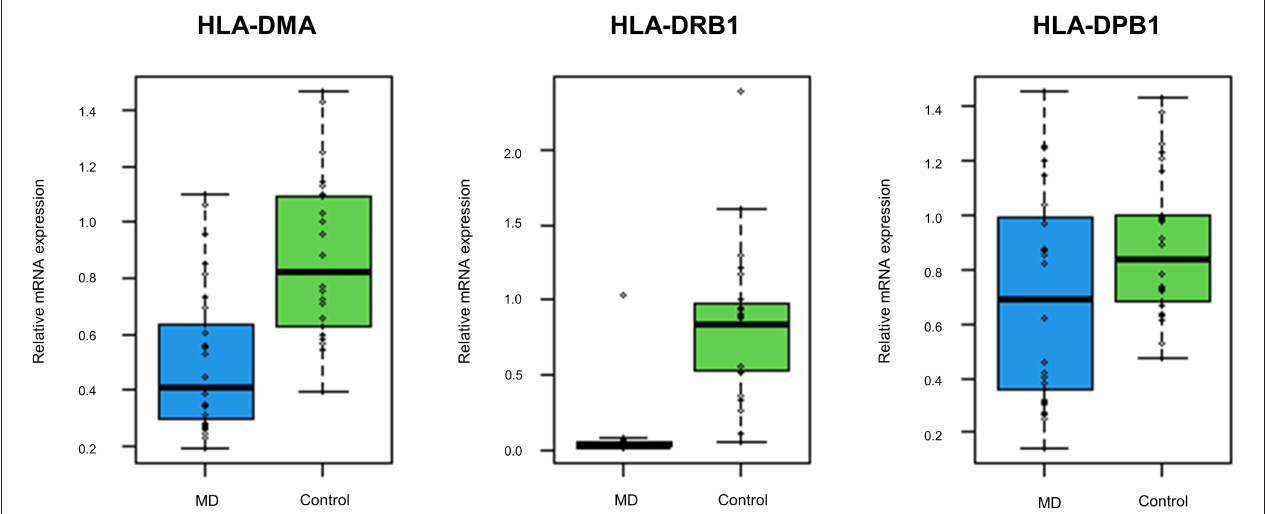
FIGURE 3 | The expression levels of the top three downregulated differentially expressed genes (DEGs) associated with the MHC protein complex using quantitative reverse transcription-polymerase chain reaction (qRT-PCR). Compared with normal controls, the mRNA expression levels of human leukocyte antigen (HLA)-DMA, HLA-DRB1, and HLA-DPB1 are significantly decreased in 30 validation cohort with the MD ( p < 0.001, p < 0.001, and p = 0.026, respectively).